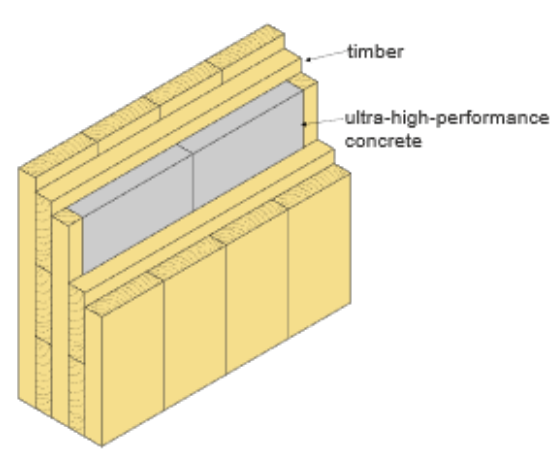
Figure 1. Wall with hybrid cross section comprised of timber and UHPC